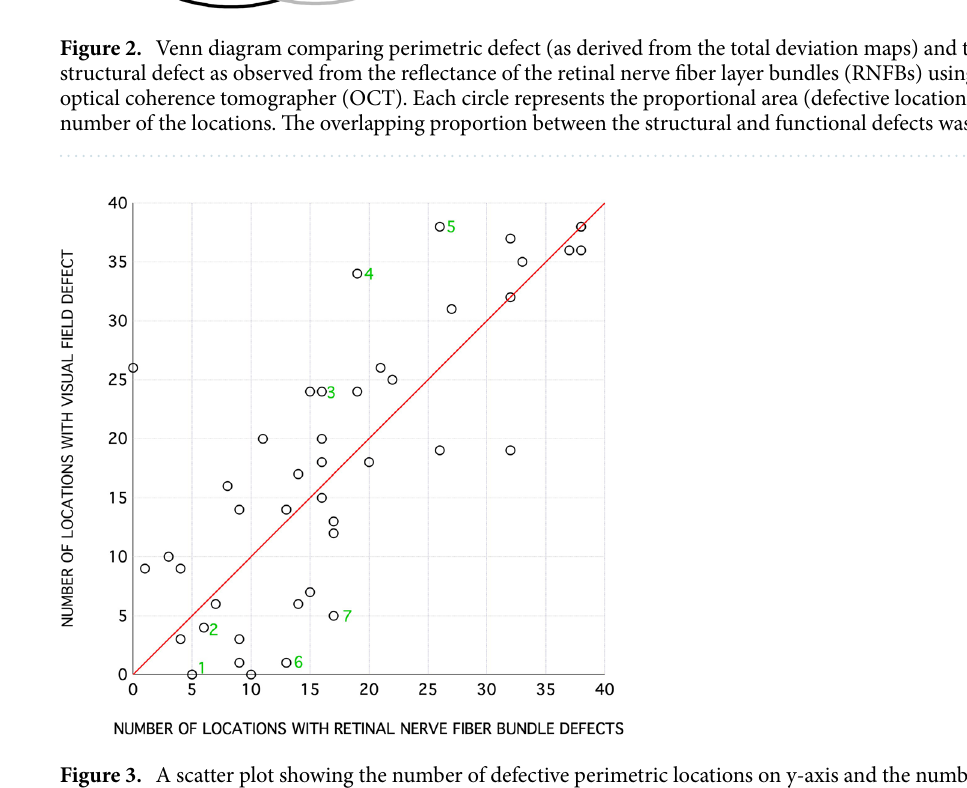
Figure 3. A scatter plot showing the number of defective perimetric locations on y-axis and the number of locations with low reflectance of the RNFL bundles on the x-axis. Symbols with numbers to their right are for the examples shown in Figs. 4 and